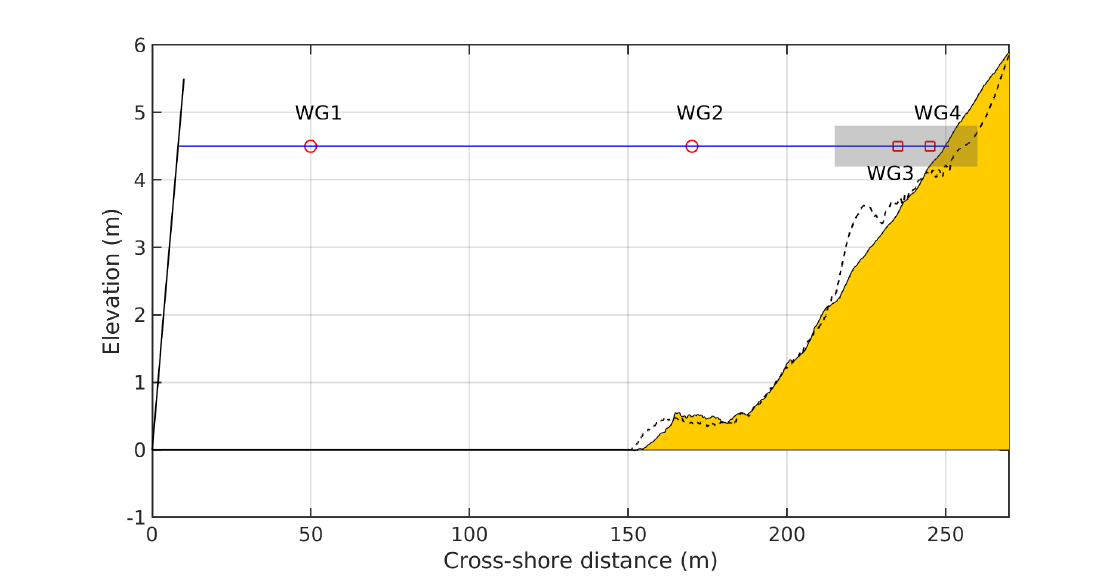
Figure 1. Bathymetric profile for case DR0 (see Table 1) with WG1 and WG2 wave gauge positions (red circles) as well as LiDAR scanner zone (grey area). WG3 and WG4 (red square) refer to virtual wave gauges derived from the LiDAR scanner measurements. The dashed line shows the profile for case SBE2 (see Table 1) indicating the inner